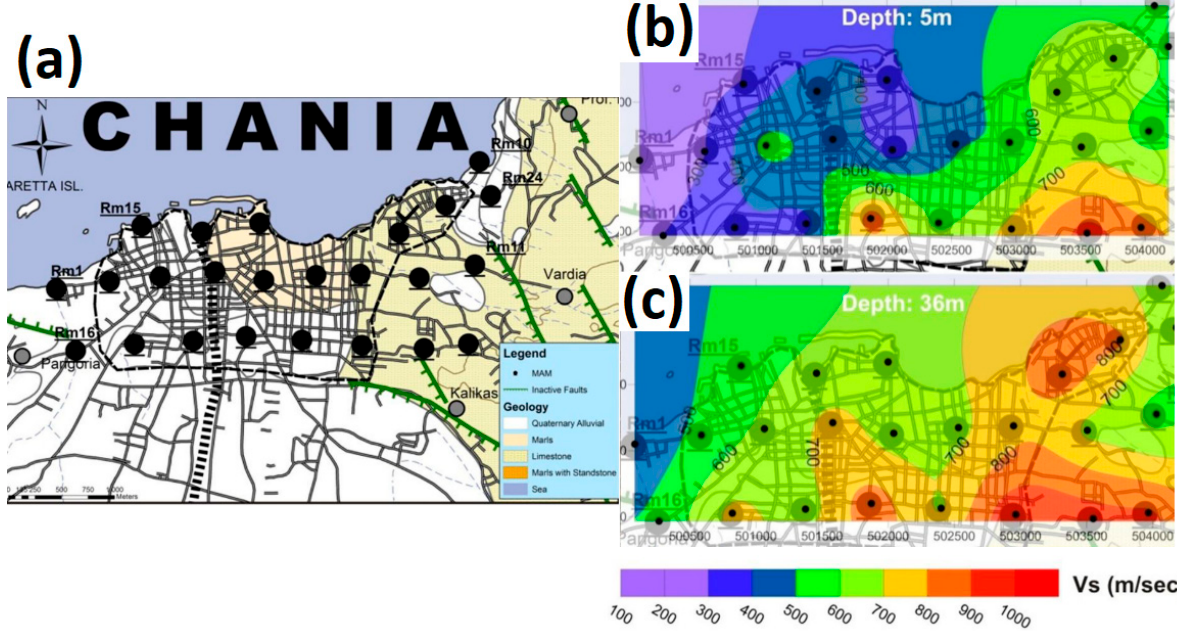
Figure 3. ( a ) Wider Chania region with MAM measurement locations (black dots) and shear-wave velocities (m/s) model for ( b ) 5 m and ( c ) 36 m depths (adopted from [35]).